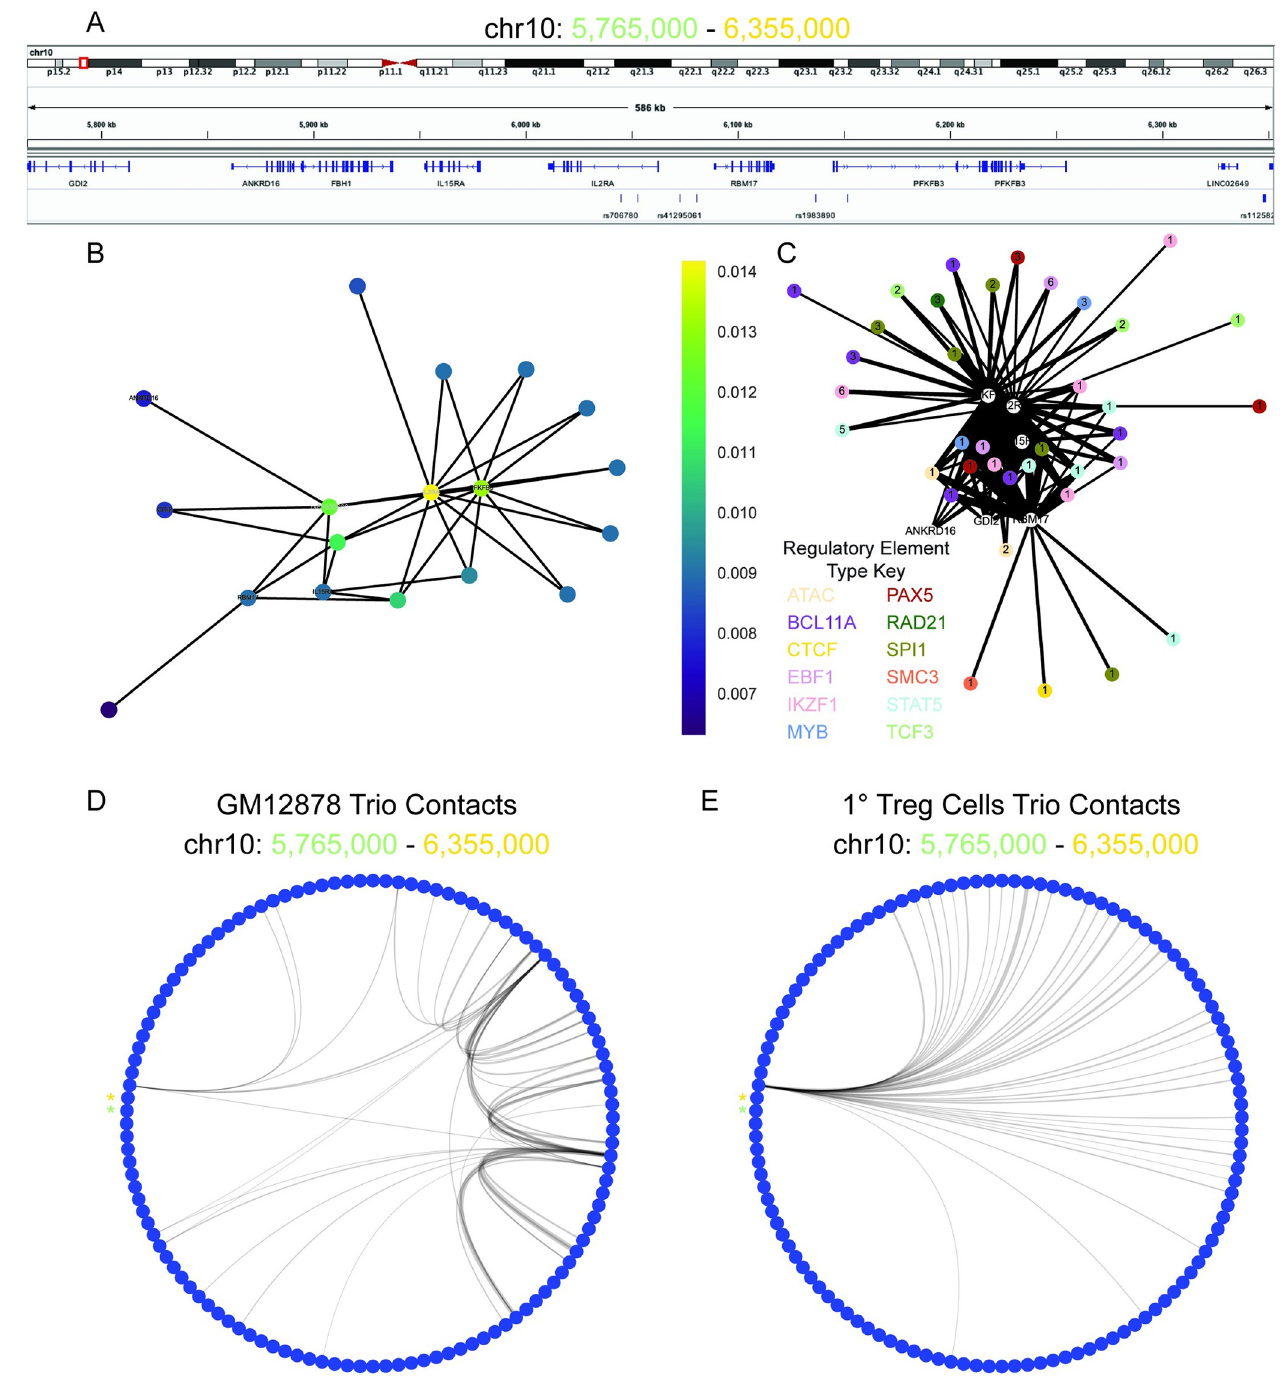
Fig 6. IL2RA is a top pipeline identified candidate. A: Visualization of the IL2RA component of interconnected pipeline genetic variant–regulatory element– gene trios (chr10: 5,765,000–6,355,000). B: Bipartite graph of the IL2RA component with gene and genetic variants as nodes and chromatin connections as edges. Node color indicates closeness centrality score with gold being most connected and purple being least connected nodes in the graph. Gene nodes are labeled, and genetic variant nodes are unlabeled. C: Bipartite graph of IL2RA component with gene and regulatory elements as nodes and chromatin connects as edges. Gene nodes are labeled and white. Regulatory element nodes are colored by type and labeled by the number of unique genetic variants contained in the regulatory element. The width of edges indicates connectivity strength as indicated by the number of unique HiChIP reads. D: Circos plot of the chromatin connectivity at 5 kb resolution in the IL2RA locus. The nodes are sections of the genome and the edges are the chromatin connectivity with the width indicating connectivity strength. An asterisk labels the starting (chr10: 5,765,000; green) and terminating (chr10: 6,355,000; gold) nodes of the plot. GM12878 (left panel) and Treg (right panel) pipeline trio contacts are